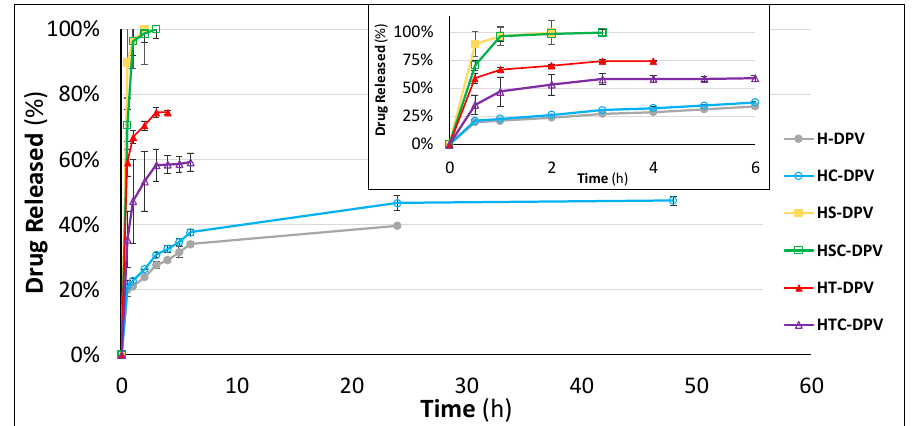
Figure 12. Drug release profiles of DPV-loaded vaginal discs in simulated vaginal fluid. The values obtained up to 6 h of trial are expanded inside the picture. Mean ± SD are presented ( n = 3). Table 3. Similarity factor (f 2 ) values obtained from the comparison of batches. Significant differences are in bold.